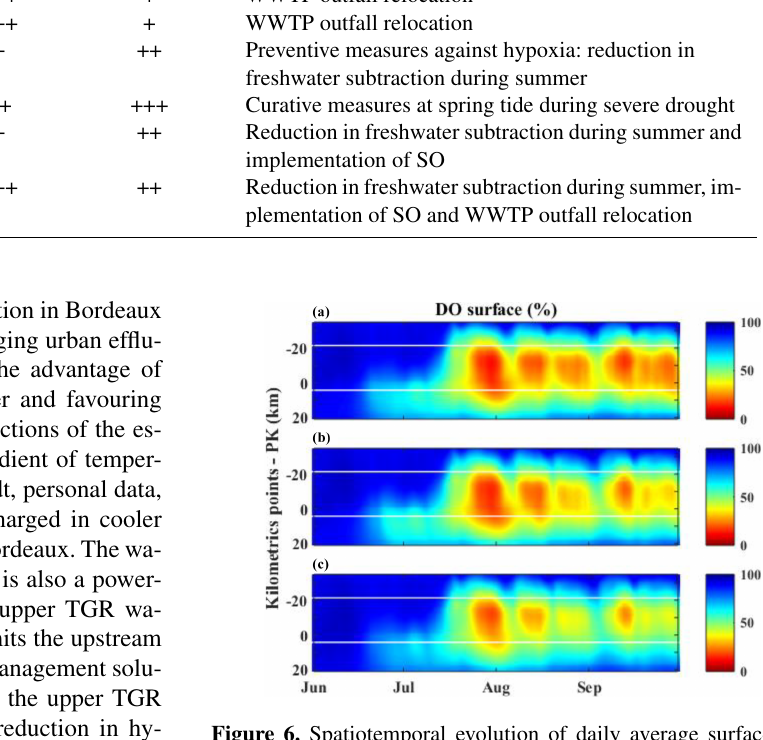
Figure 6. Spatiotemporal evolution of daily average surface DO (saturation in %) along the tidal Garonne River section for the sce- narios of reference (a) , combining + 10ms − 1 of river flow and re- duction of 50% of SO releases (b) , and combining + 10m 3 s − 1 of river flow, a reduction of 50% of SO releases and urban effluent discharges at KP15 (c) . The y axis represents the kilometric points, and the white lines represent Bordeaux and